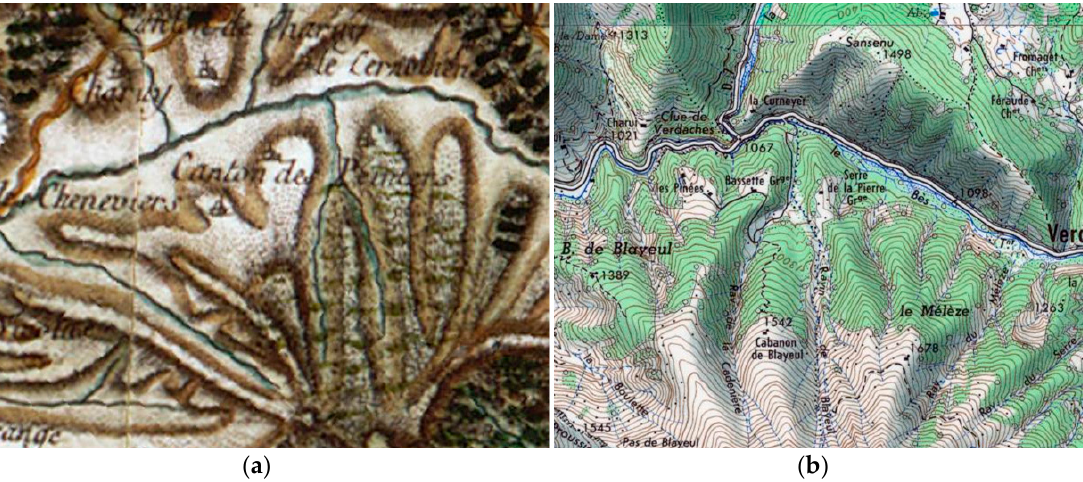
Figure 1. Cartographic representation of terrestrial relief in maps in Southern France: Cassini map, 18th century ( a ); IGN map, 1957 ( b ).